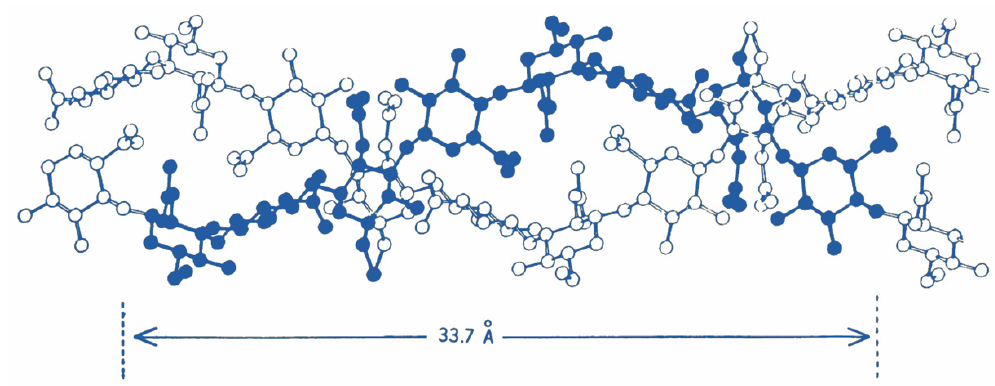
Figure 5. Hyaluronan molecules form secondary structures, including the proposed anti-parallel double helix shown here. These arrangements occur as a result of significant intra- and intermolecular hydrogen bonding, which influences the viscoelastic behavior of colloidal mixtures. Reproduced from Webber et al. [56], with permission.